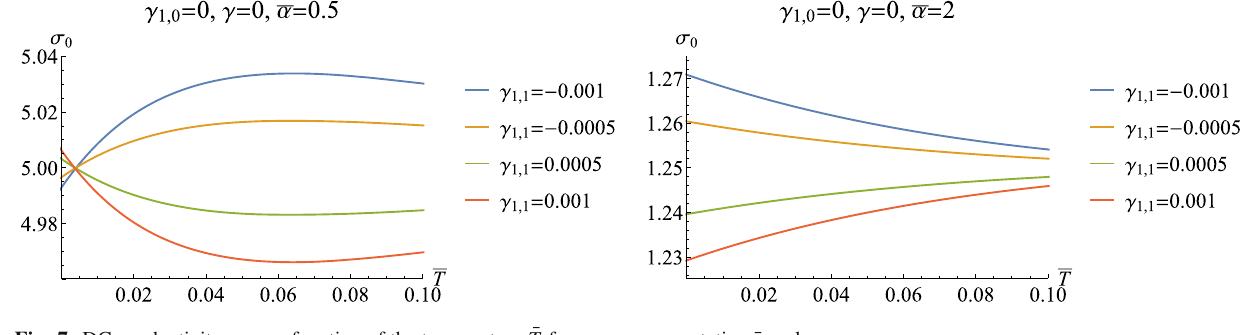
Fig. 7 DC conductivity σ 0 as a function of the temperature ¯ T for some representative ¯ α and γ 1 , 1